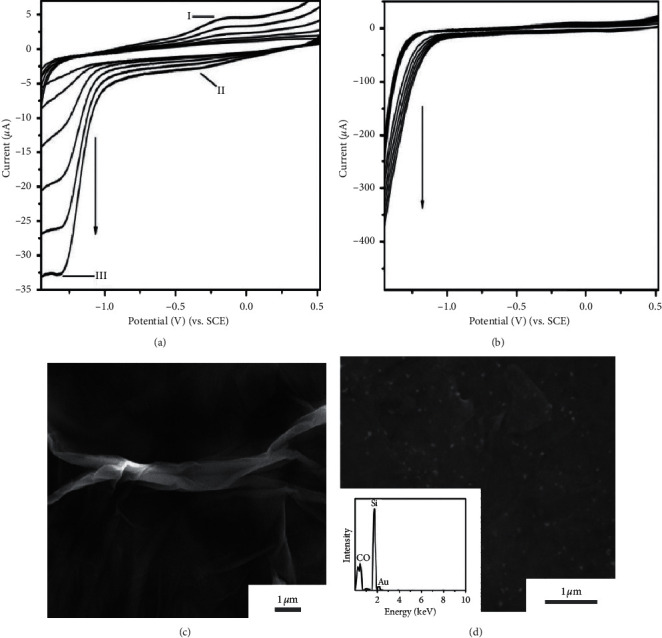
CV for the electrodeposition of (a) 1.0 mg·mL−1 GO and (b) 1.0 mg·mL−1 GO + 200 μM HAuCl4 in 0.05 M pH 9.0 CBS at a scan rate of 20 mV·s−1. Typical SEM images obtained from (c) rGO and (d) rGO-Aunano film on Si substrate, respectively. Inset: EDS pattern of the rGO-Aunano.